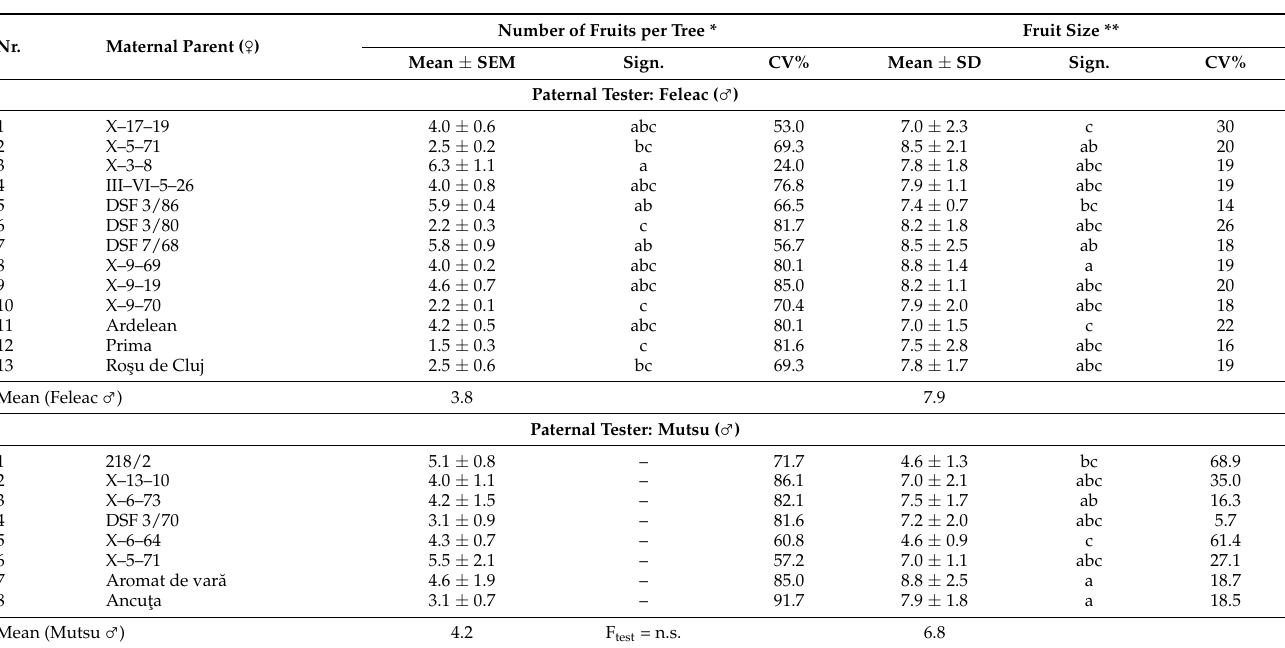
Table A2. The number of fruits per tree and the fruits’ size in F 1 apple hybrids in the offspring of testcross hybridization with the five cultivars used as paternal